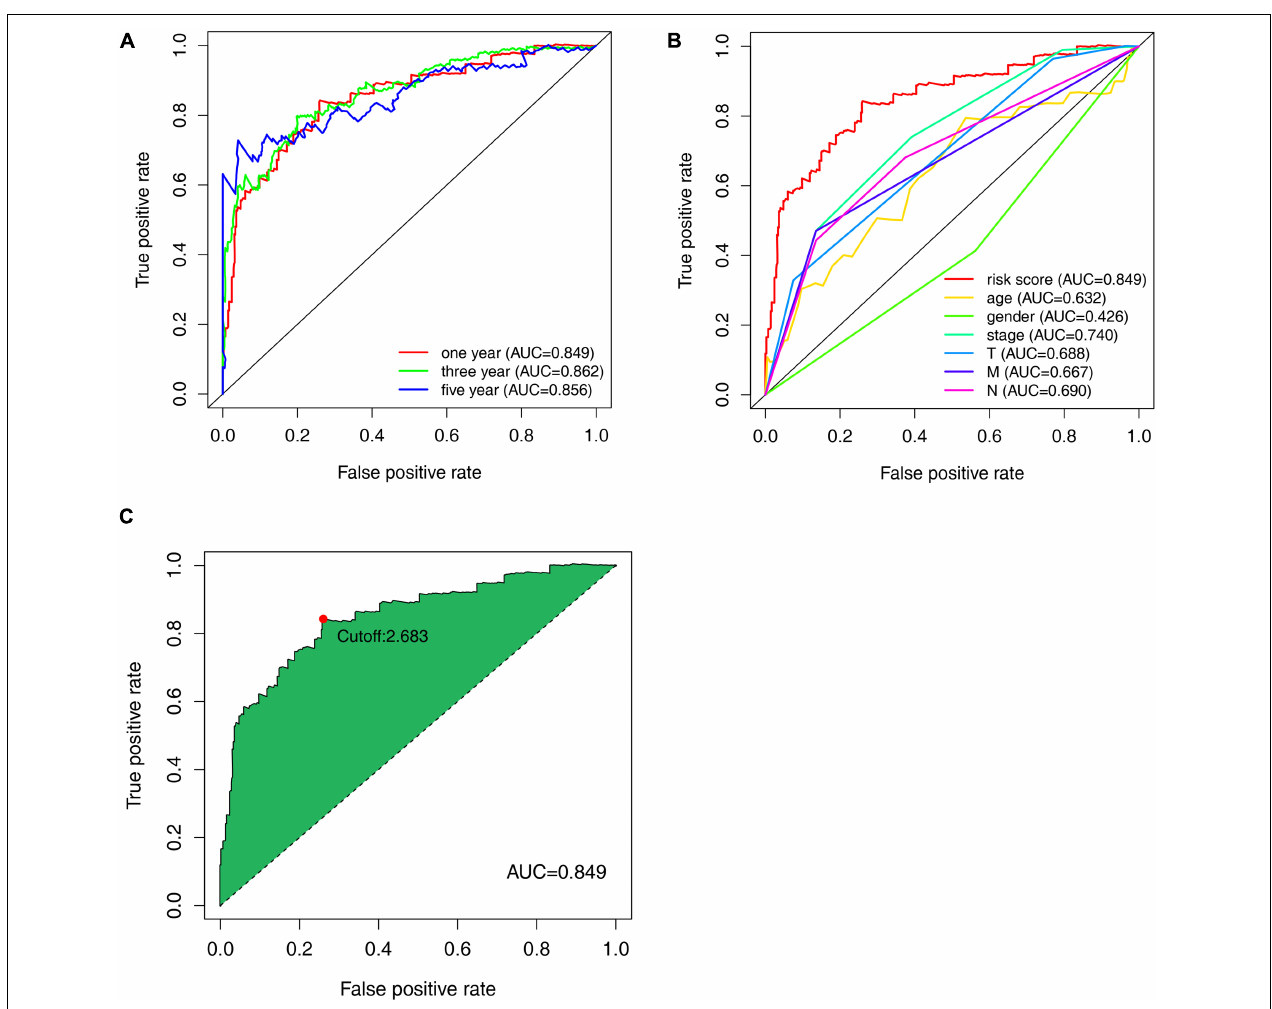
FIGURE 4 | Evaluation of the constructed model through the receiver operating characteristic (ROC) curve. (A) Time-ROC curves of the constructed model were compared in accordance with the 1–, 3–, and 5-year ROC. The value of each area under each (ROC) curve (AUC) was over 0.85. (B) ROC curve analyses in predicting the overall survival (OS) of patients for risk score, age, gender, stage, T, M, and N (C) The optimal cut-off value was the maximum inflection point, according to the time-dependent ROC curve